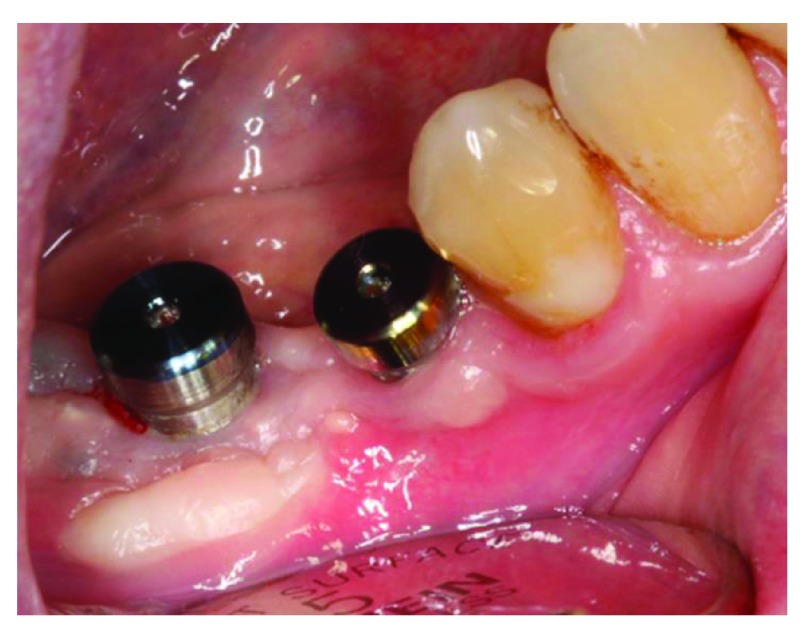
Implant placement.